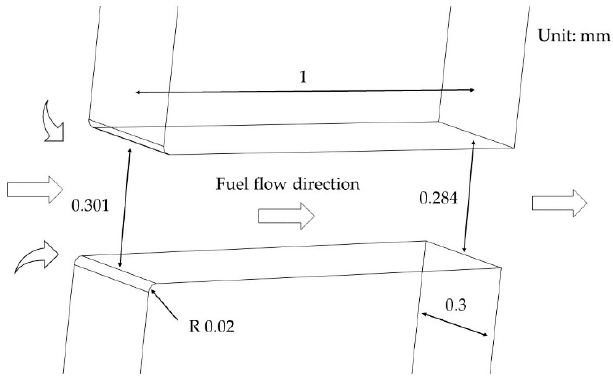
Figure 1. The microchannel geometry of the Winklhofer.